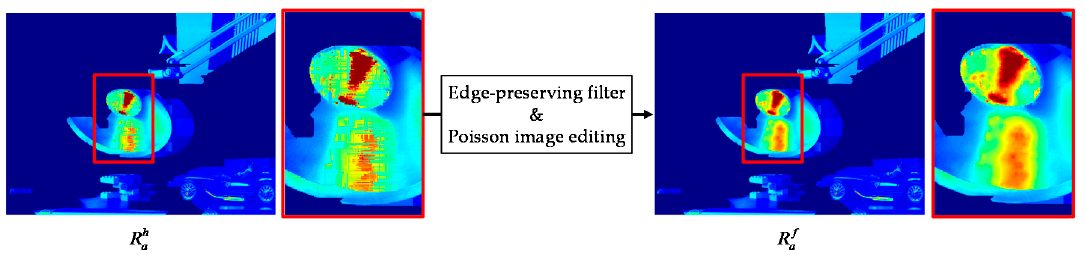
Figure 12. Restoration radiance values for holes.